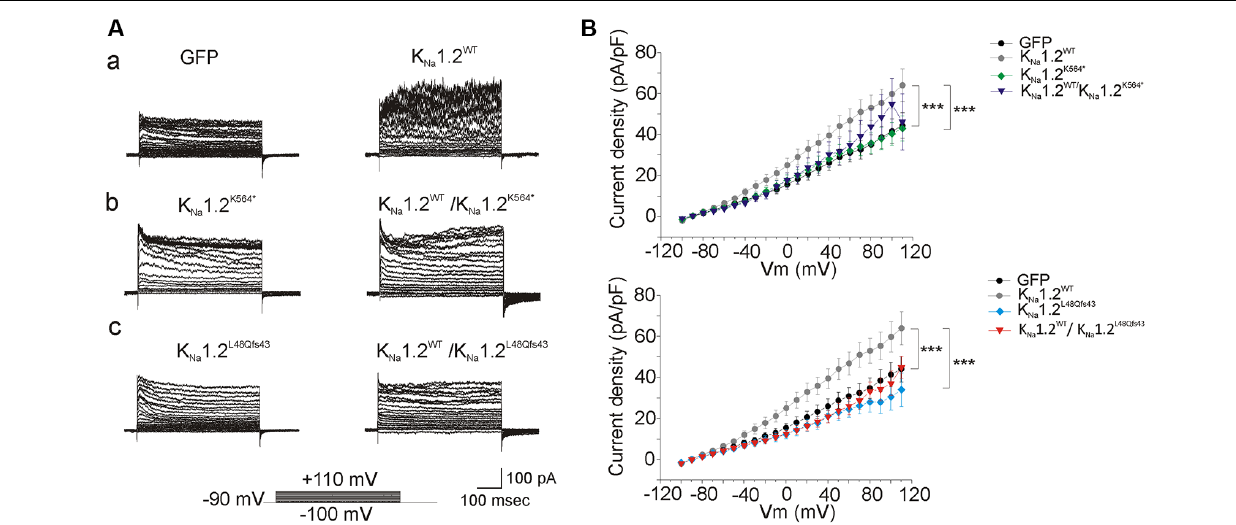
FIGURE 3 | Functional analysis of homomeric wild type and mutant human K Na 1.2 channels in chinese hamster ovary (CHO) cells. (A) Current response to 10 milliVolts (mV) voltage steps command from − 90 mV to +110 mV for 500 ms in cells transfected with plasmids encoding: (a) green fluorescent protein (GFP,